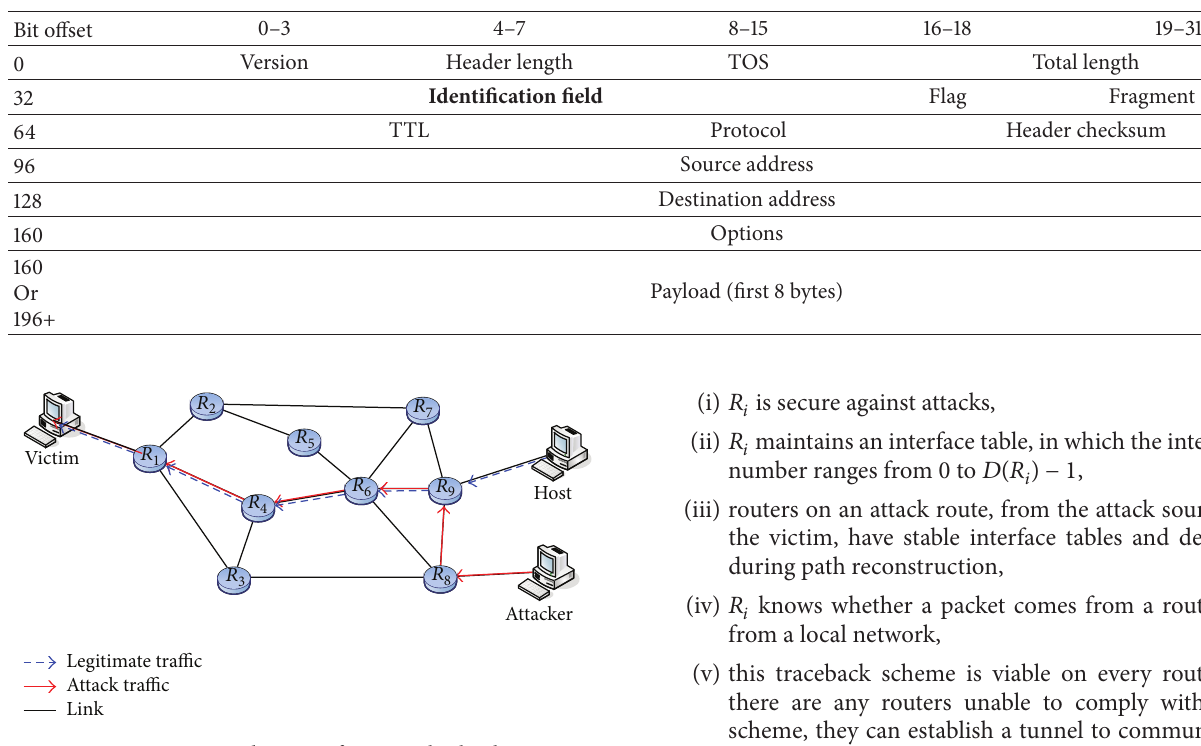
Figure 1: An example setup of our traceback